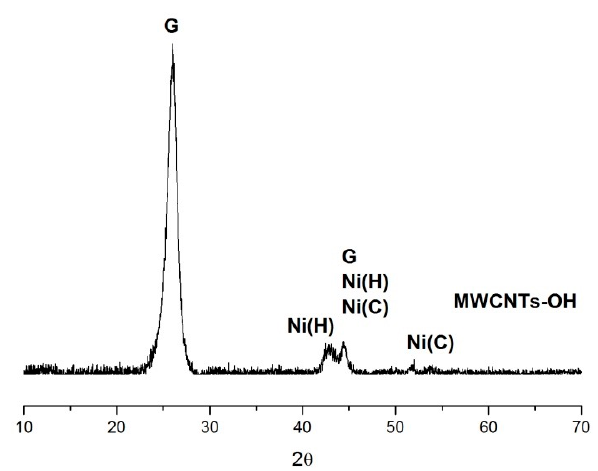
Figure 4. X-ray diffraction (XRD) pattern of MWCNTs–OH (G: Graphite, Ni(C): Cubic Nickel, Ni(H): Hexagonal Nickel).